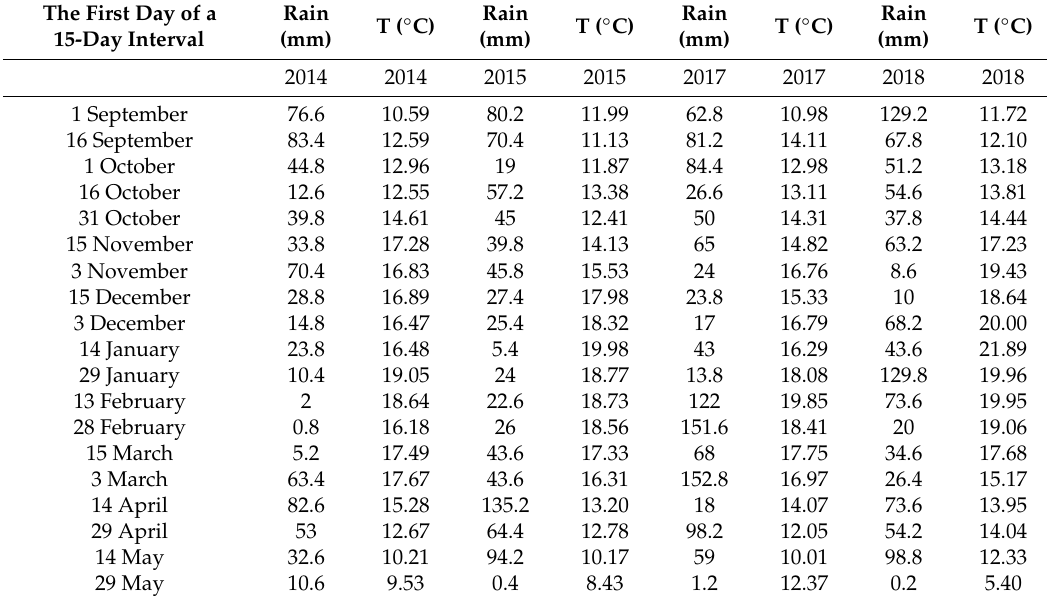
Table 1. Historical meteorological data for the crop growing season in 2014, 2015, 2017 and 2018 for site 1 (the sum of rainfall and the average temperature over 15-day